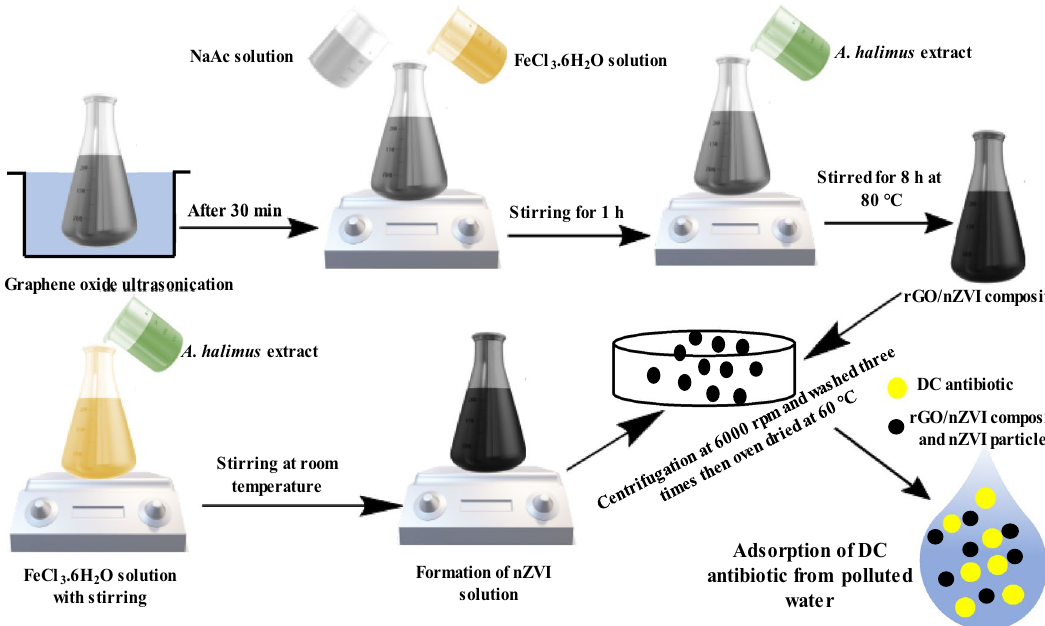
Figure 1. Schematic diagram and digital photos for the green synthesis of rGO/nZVI composite and nZVI using Atriplex halimus extract and removal of DC antibiotic from polluted